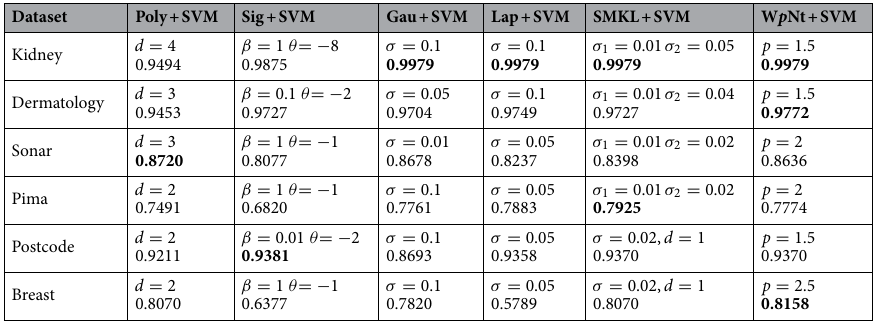
Table 4. The fivefold cross-validation classification recall based on the SVM algorithm with different kernel functions. Significant values are in bold.